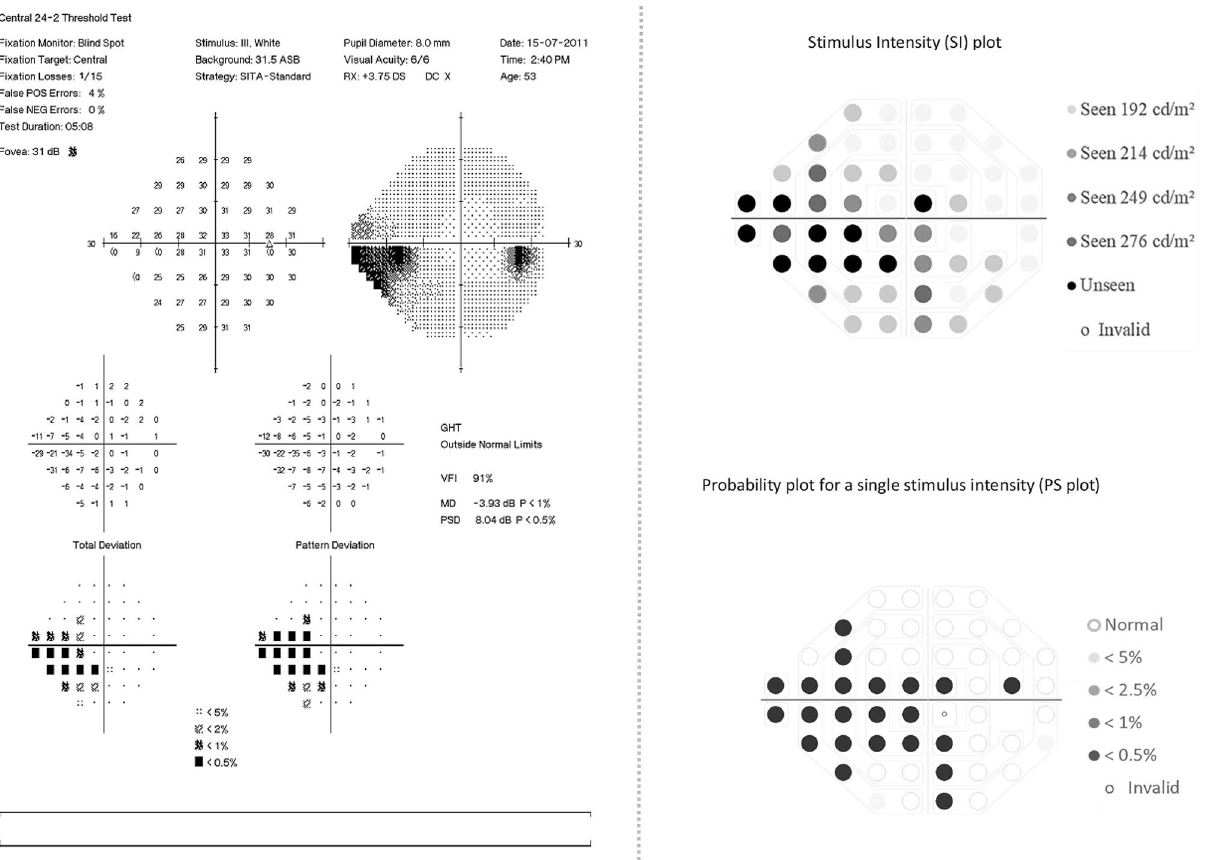
Figure 5. Illustration of HFA and EMP visual field report for a moderate glaucoma patient; Left panel: presentation of HFA 24–2 SITA-standard visual field report showing incomplete inferior arcuate defect. HFA indicates Humphrey visual field analyser; SITA, Swedish Interactive Threshold Algorithm. Right panel: the EMP plots for the same patient in 5, left panel: top panel presenting saccadic reaction time (SRT) plot at 54 points with corresponding numerical grey scale; Bottom panel presenting probability plot corresponding to the SRT responses at the stimulus intensity 214 cd/m 2 presents visual field defect inferiorly with additional areas of delayed SRT superiorly. EMP indicates eye movement perimetry ; HFA, Humphrey field analyzer; SITA, Swedish interactive threshold algorithm.